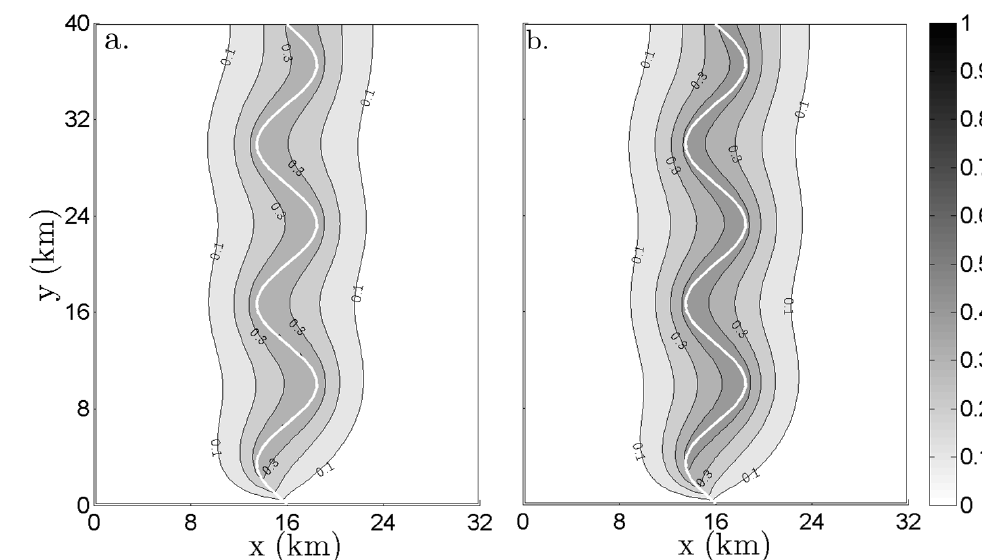
/Q ) in an aquifer with K = 5 m d − 1 and a r p = 3 × 10 − 3 m d − 1 and ( b ) K = 4 × 10 − 3 m d − 1 after r r